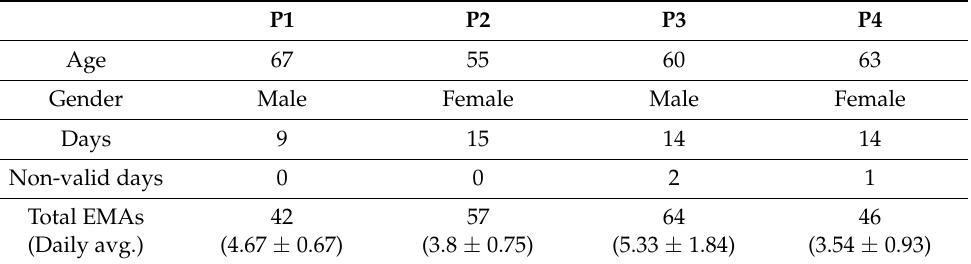
Table 12. Participants’